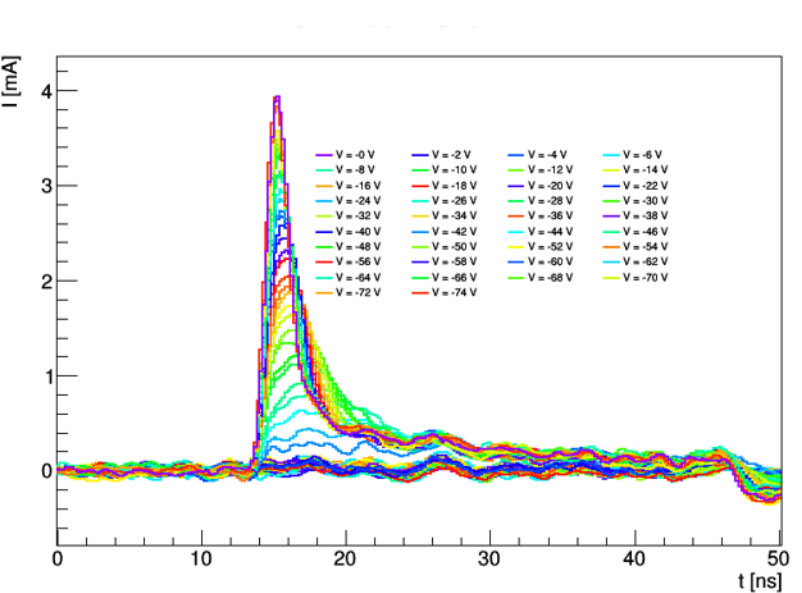
Figure 7. Recorded waveforms at different bias voltages for an unirradiated LGAD.